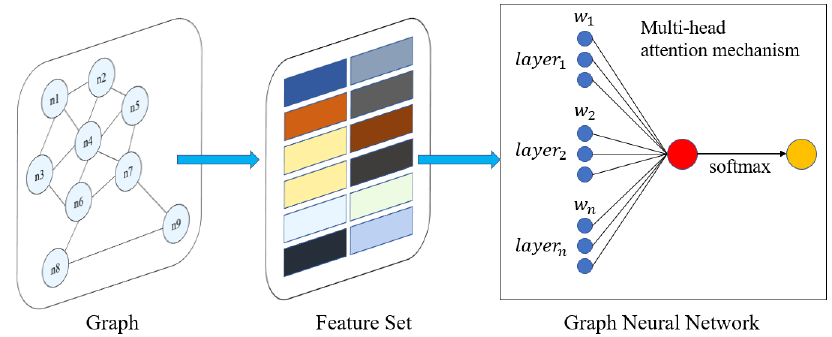
Figure 6. The architecture of GATR. The specific process is described as